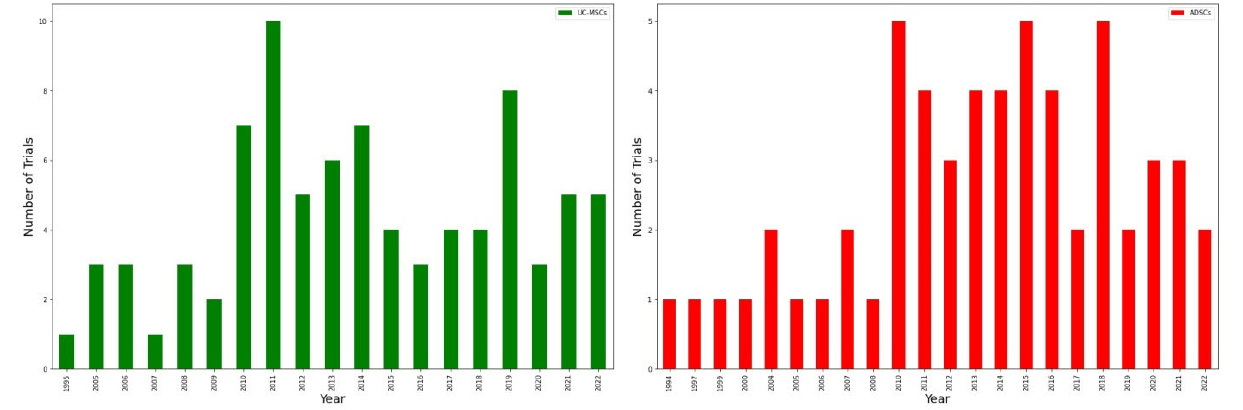
Figure 7. ADSCs and UC-MSCs clinical trials. On the left (green) is a graph for UC-MSCs and on the right (red) for ADSCs. Both are a source for mesenchymal stem cells and have generally similar graphs, and, therefore, approximately the same popularity in the clinic. On the other hand, in 2016 and 2020 there is a drop to three clinical trials for UC-MSCs, while for ADSC’s such drop was registered in 2017 and 2019 (two trials in each year). Overall, UC-MSCs seem to be more frequently applied with the highest peak in 2011 when 10 trials were registered. In turn, ADSCs had three major peaks in 2010 (5 trials), 2015 (5 trials), and 2018 (5 trials).